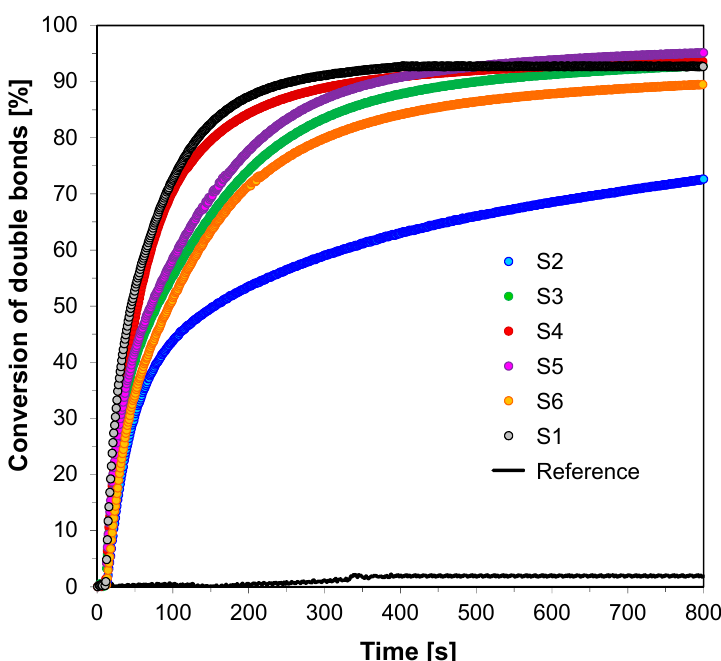
Figure 12. Conversion of double bonds of TMPTMA recorded during thiol-ene photopolymerization of TMPTMA and MERCAPTO composition with binary initiating system—HIP and fluorescent probes—under UV-LED 365 nm (95 mW/cm 2 ) irradiation.